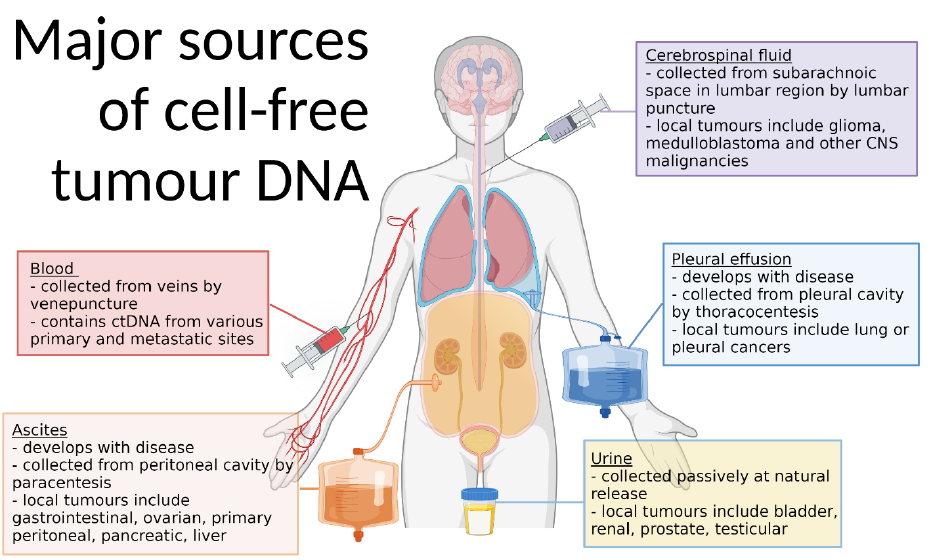
Figure 2. Major sources of cell-free tumour DNA . ctDNA can be sourced from many body fluids, including blood, ascites, cerebrospinal fluid, pleural effusions, and urine. These fluids, though often also containing ctDNA from non-local tumours, are particularly advantageous due to their contact with tumours in the anatomical locations indicated. All fluids are collected by minimally invasive or non-invasive methods, and pleural effusions, ascites, and sometimes cerebrospinal fluid are inci- dentally collected as symptom management. Created with BioRender.com (accessed on 8 February 2022). CNS, central nervous